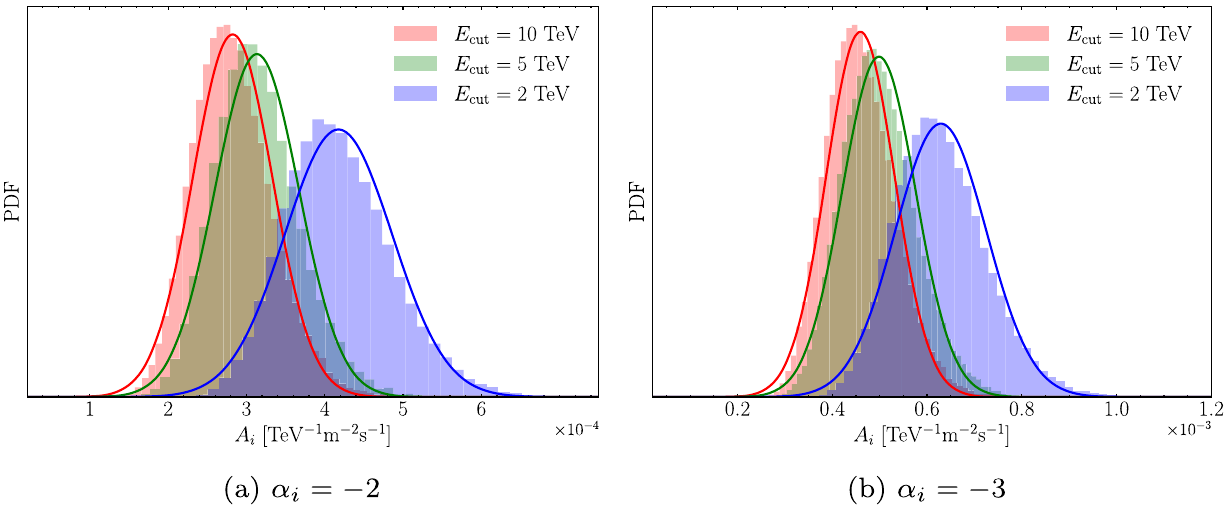
Fig. 1 Posterior probability distribution functions of A i estimated in the case of E cut = 10 , 5 , 2 TeV for α i = − 2 and α i = − 3, respectively